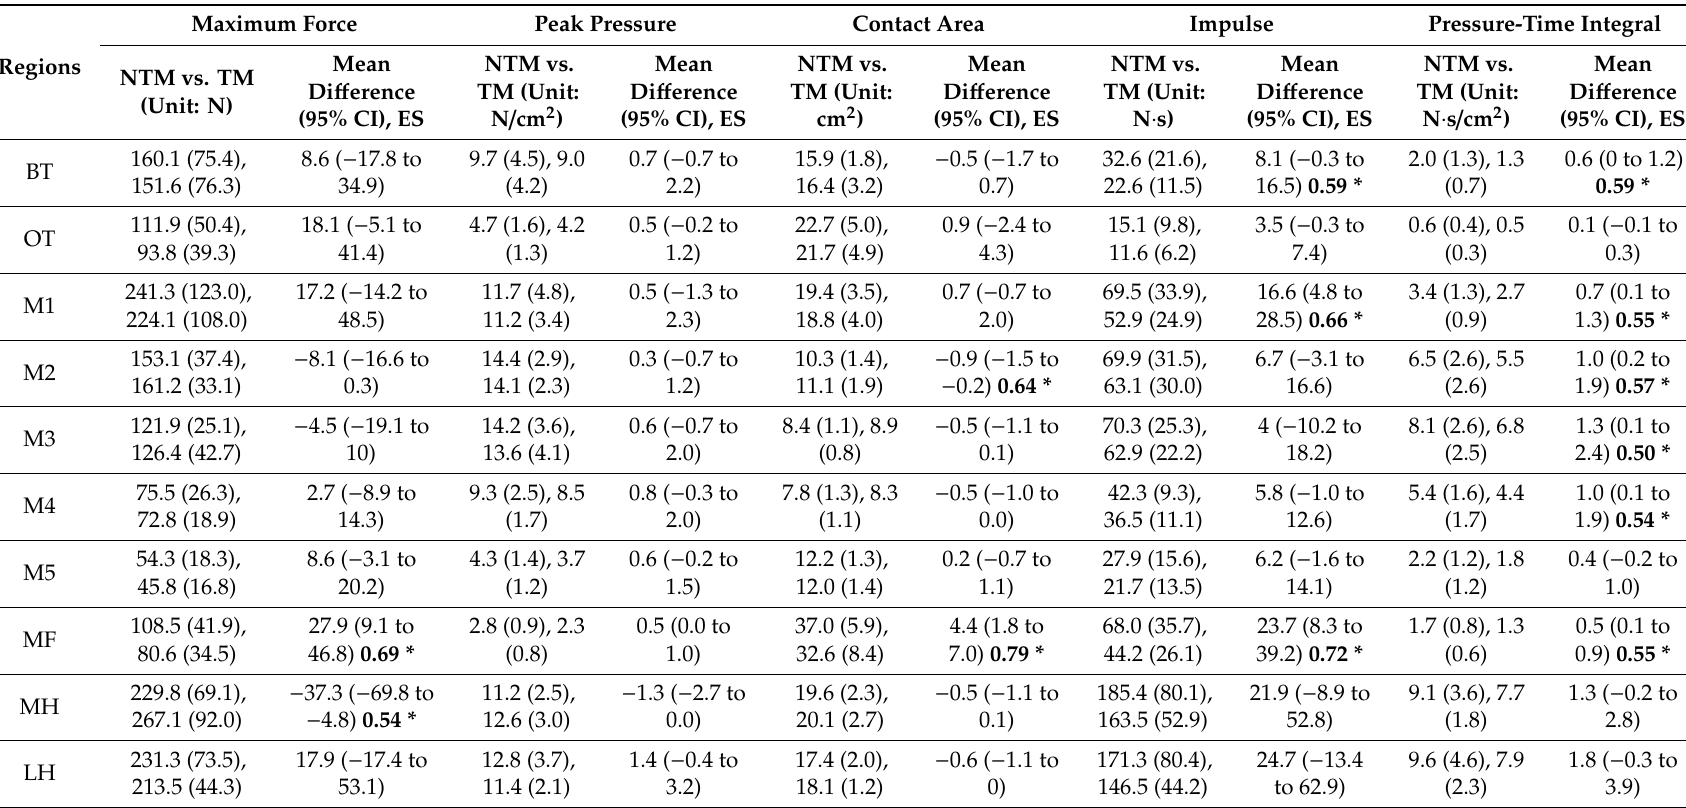
Table 1. The plantar pressure during take-o ff in Non-Toe-Manipulation ( NTM ) and Toe-Manipulation ( TM ) sessions, including mean (SD), mean di ff erence, 95% confidence intervals and e ff ect sizes (ES) (Cohen’s d). * indicates significance with p < 0.05.